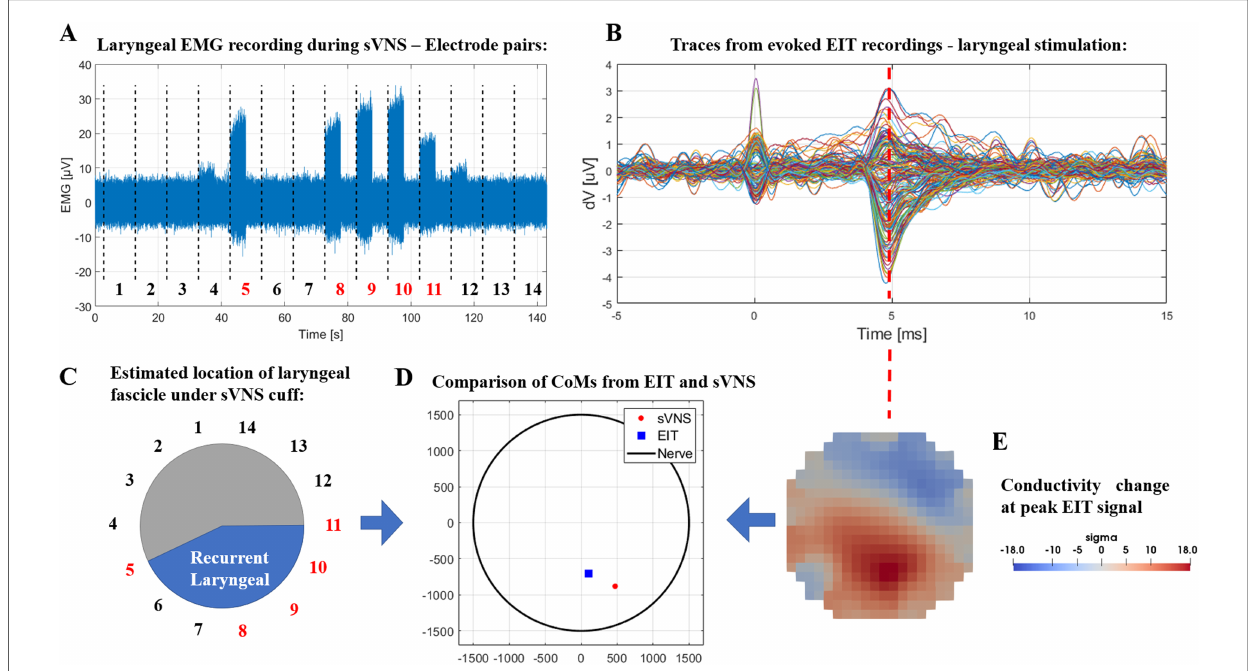
FIGURE 4 ( A ) Laryngeal EMG traces from sVNS of the cervical vagus nerve. ( B ) Vagus nerve EIT traces from evoked stimulation of the recurrent laryngeal branch. ( C ) Estimated location of the recurrent laryngeal fascicle inside the cervical vagus nerve as identi fi ed by sVNS/EMG ( C ) or EIT ( E ). ( D ) Centers-of-Mass identi fi ed from both techniques are overlayed in the lower central